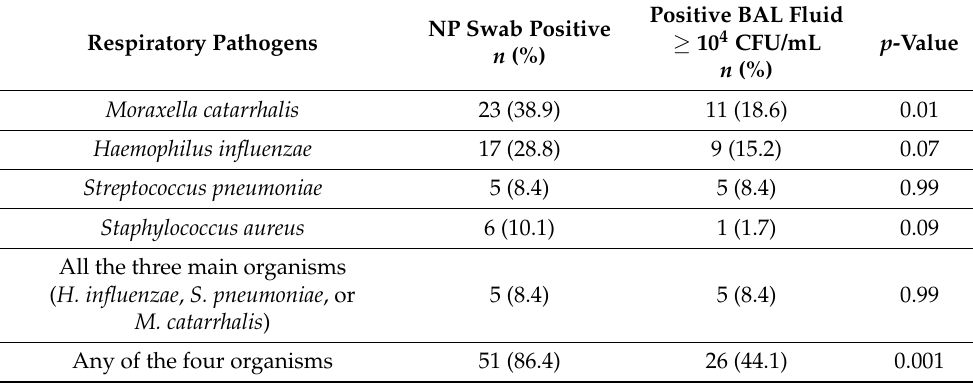
Table 2. Prevalence of positive nasopharyngeal and lower airway respiratory bacterial pathogens in children with clinical persistent bacterial bronchitis ( n =